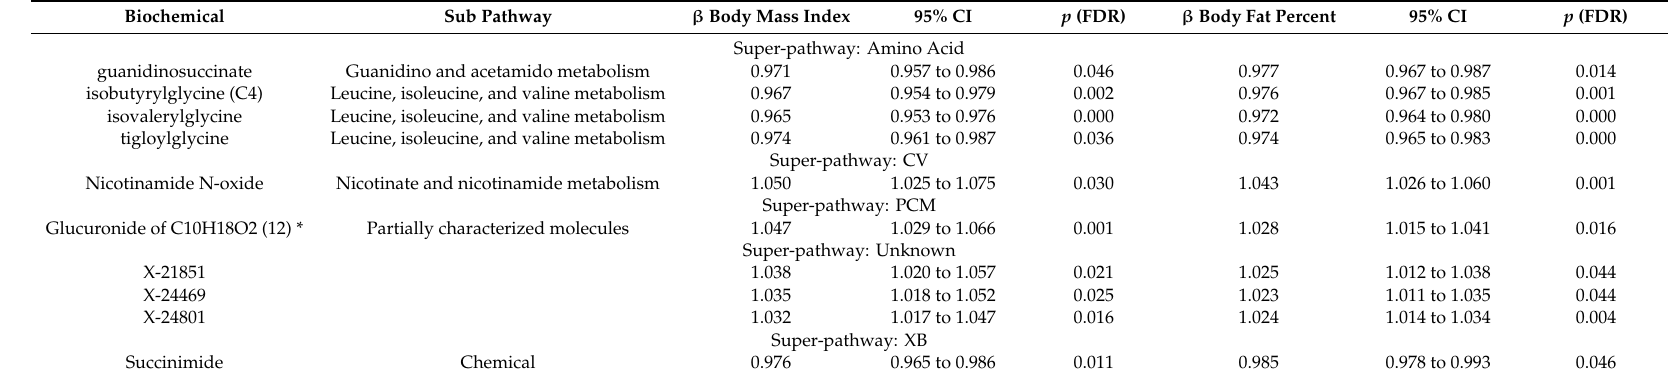
Table A3. Metabolites associated with both body composition